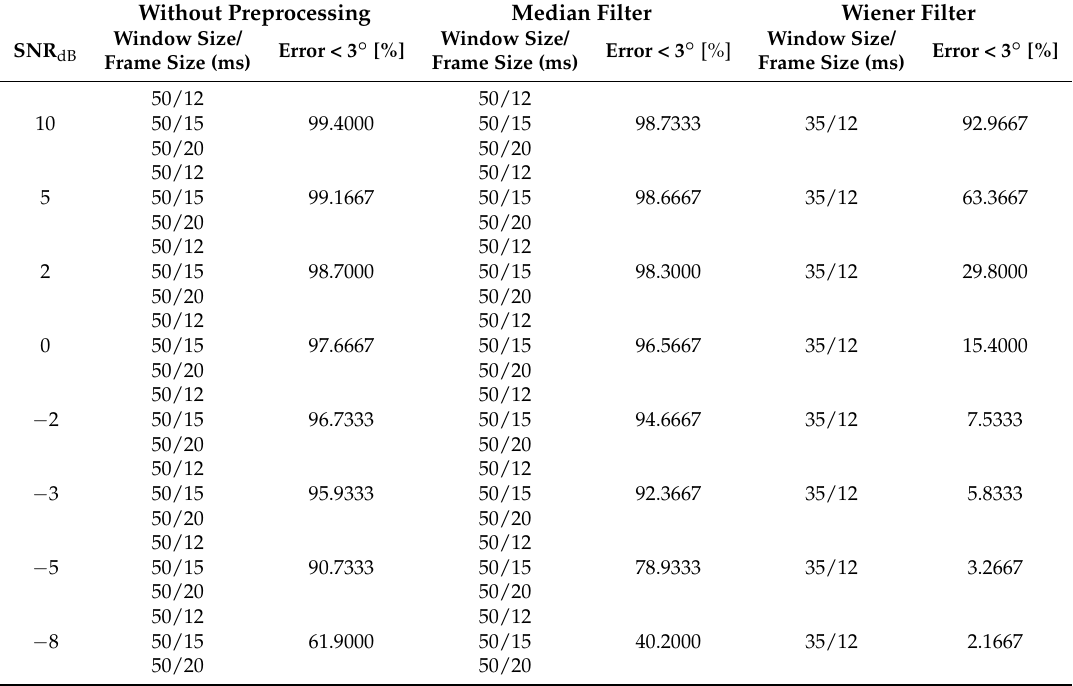
Table 3. Multi-channel Blind Source Separation (MBSS) Simulation: The best parameters per SNR. Without Preprocessing Median Filter Wiener